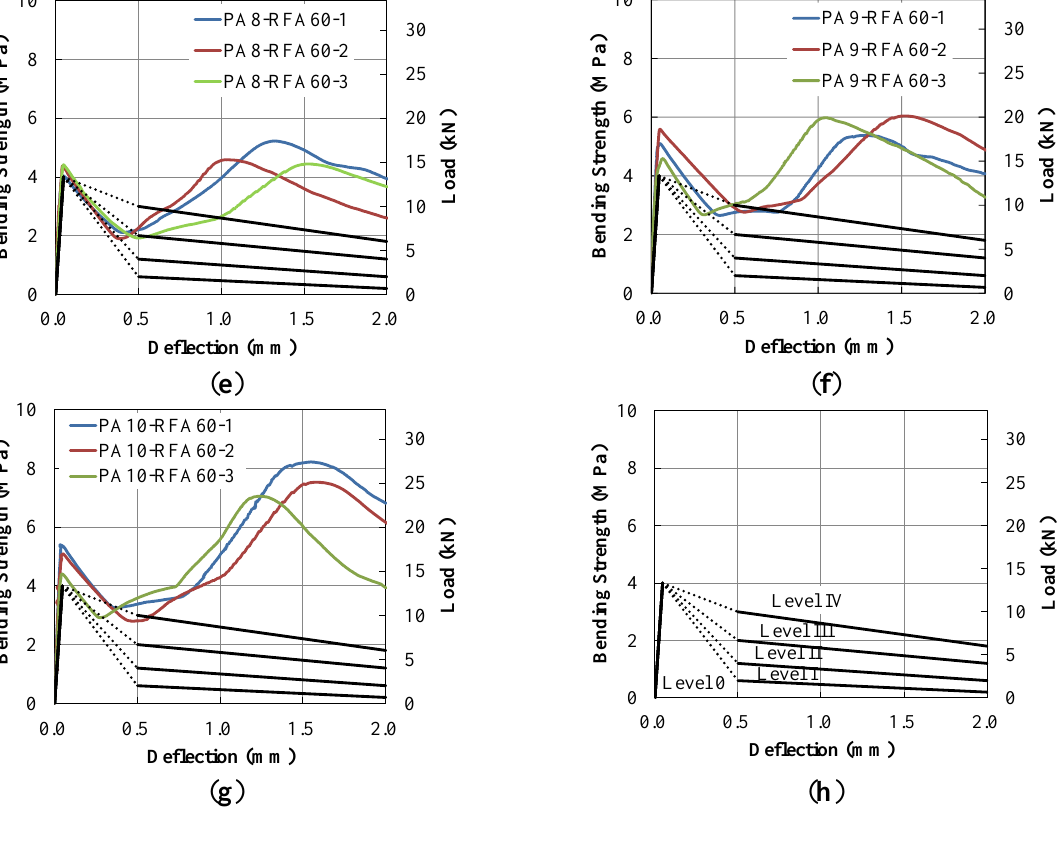
Table 6. Toughness performance level